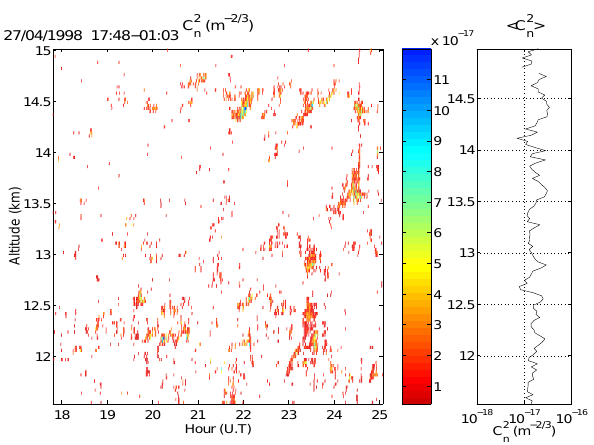
Fig. 3. Same as Fig. 2 but for 28 April